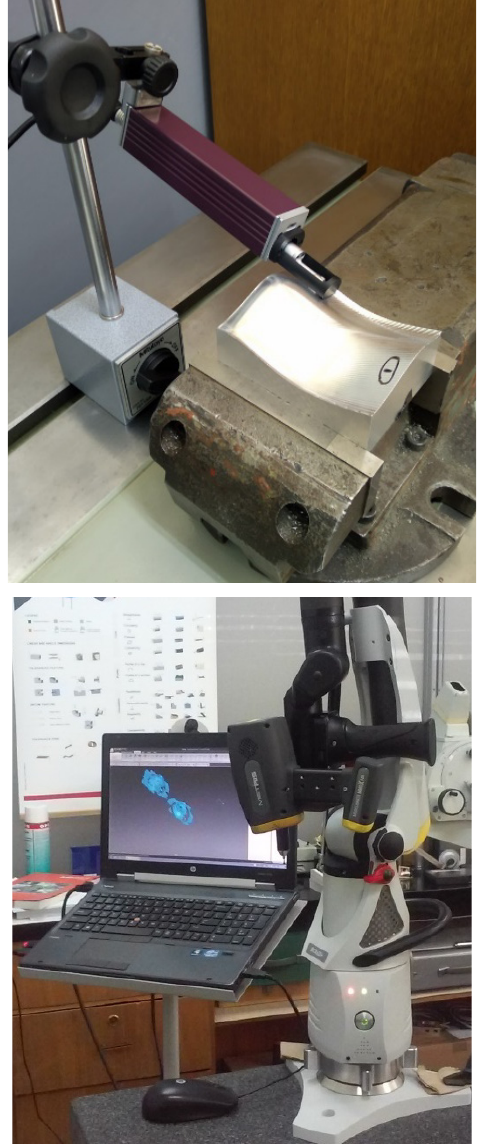
Figure 3. Measuring equipment for surface roughness (above) and dimensional accuracy